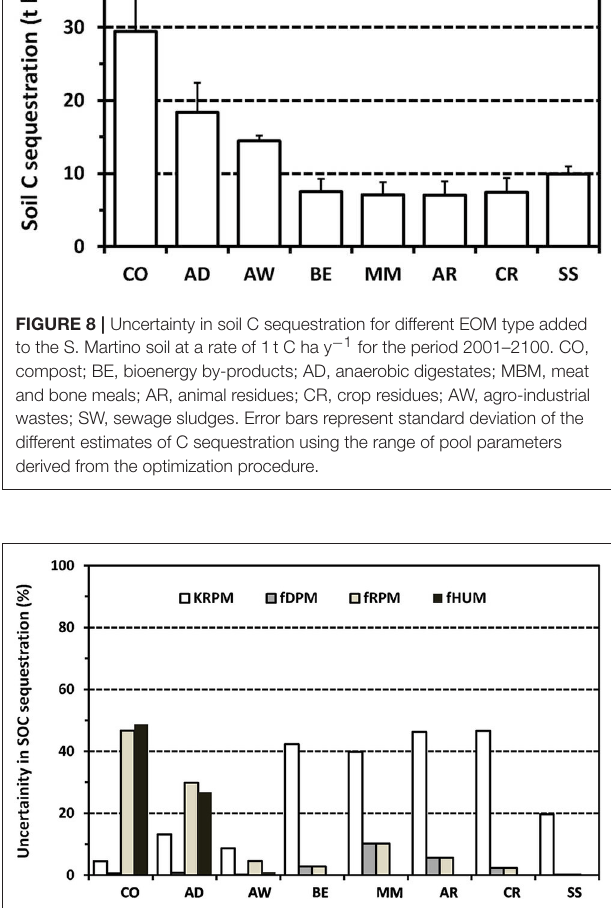
as application of the same amount of C may result in a